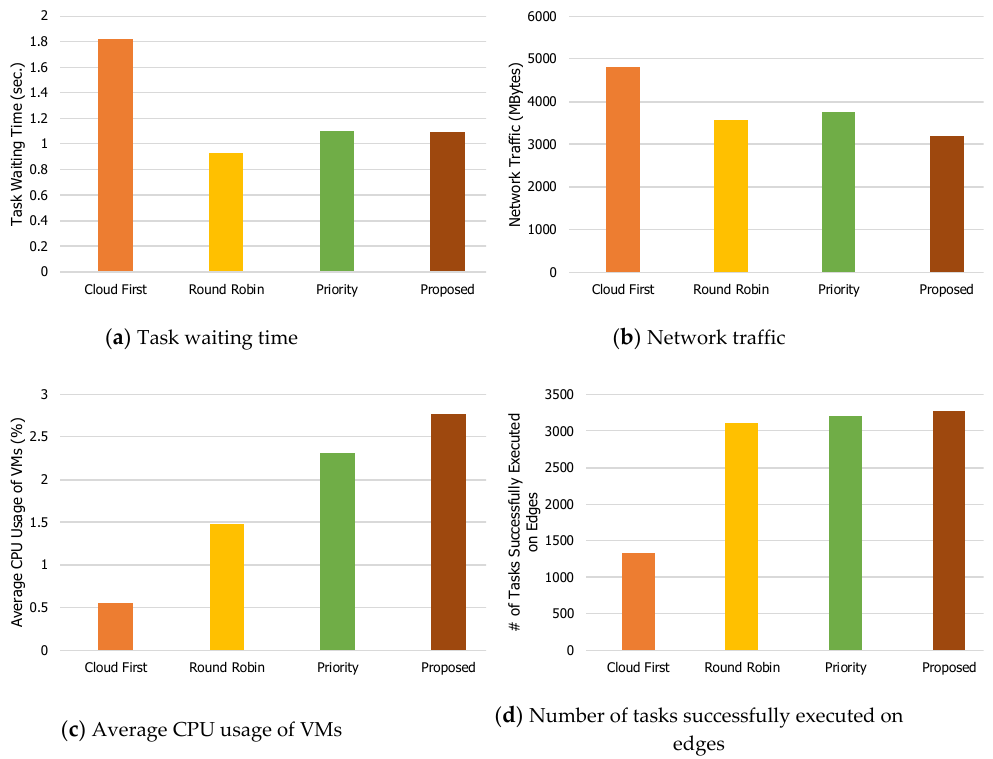
Figure 6. Performance comparisons when the number of mobile devices is 600.